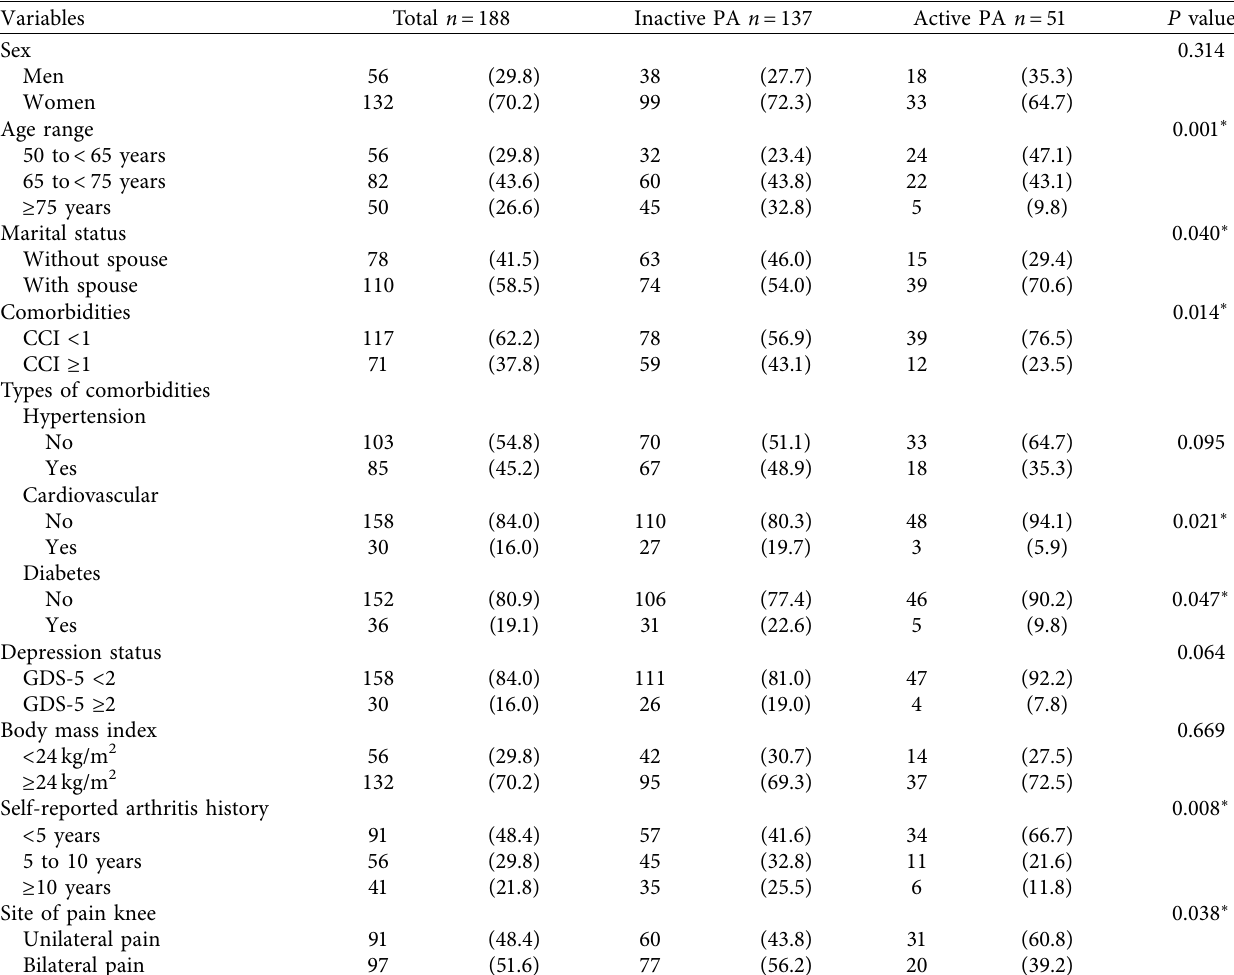
Table 1: The comparison of categorical variables between inactive and active physical activity groups in people with KOA ( n � 188).